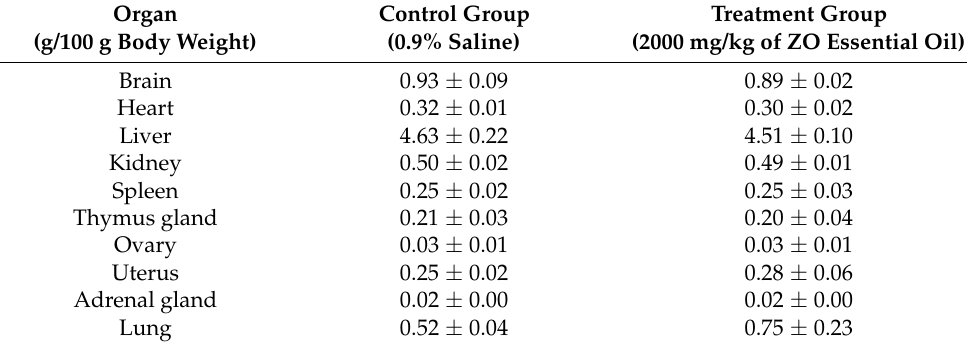
Table 5. Relative organ weights of the control group (0.9% saline) and the treatment group (2000 mg/kg of ZO essential oil). Data shown are the mean ± SD ( n = 5 rats/group). All data were analyzed using Student’s t -test ( p <